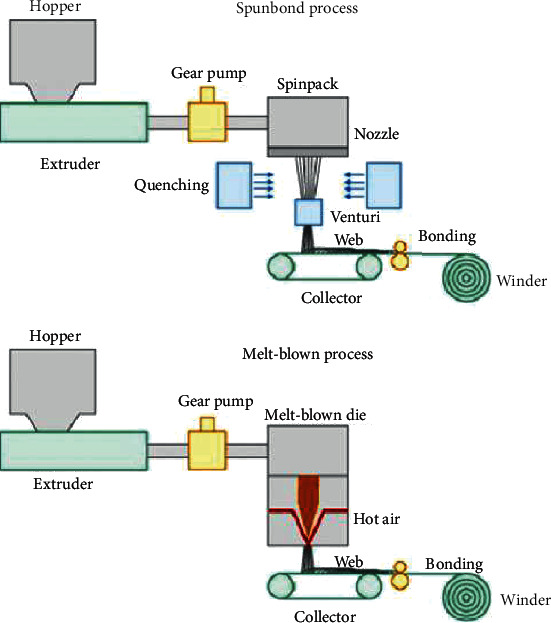
Schematic illustration of spunbond and melt-blown process. Republished with permission from Ref. [59]. Copyright 2015, Butterworth-Heinemann.